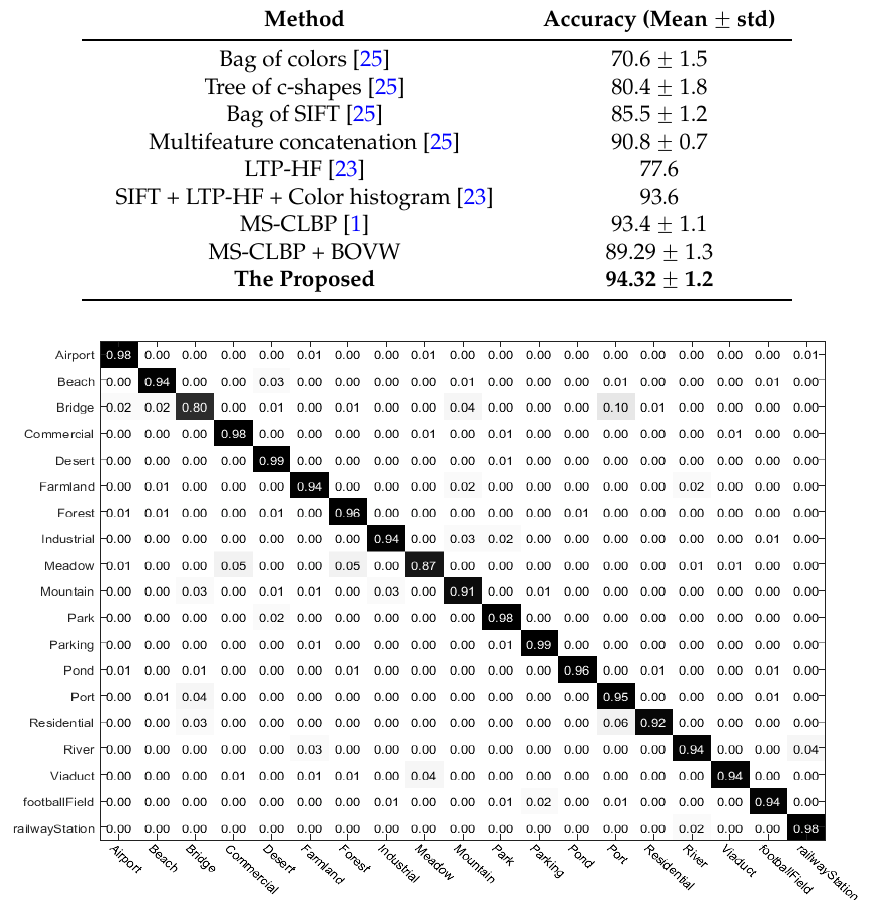
Figure 15. Confusion matrix of proposed method for the 19-class satellite scene dataset.